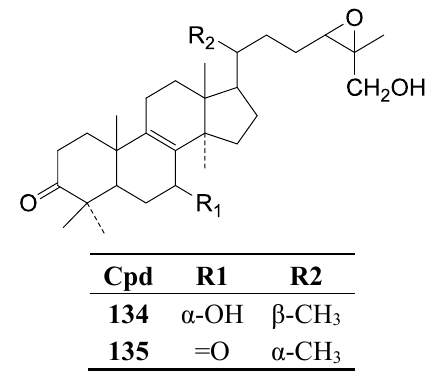
Figure 13. Structures of compounds 134 and 135 .